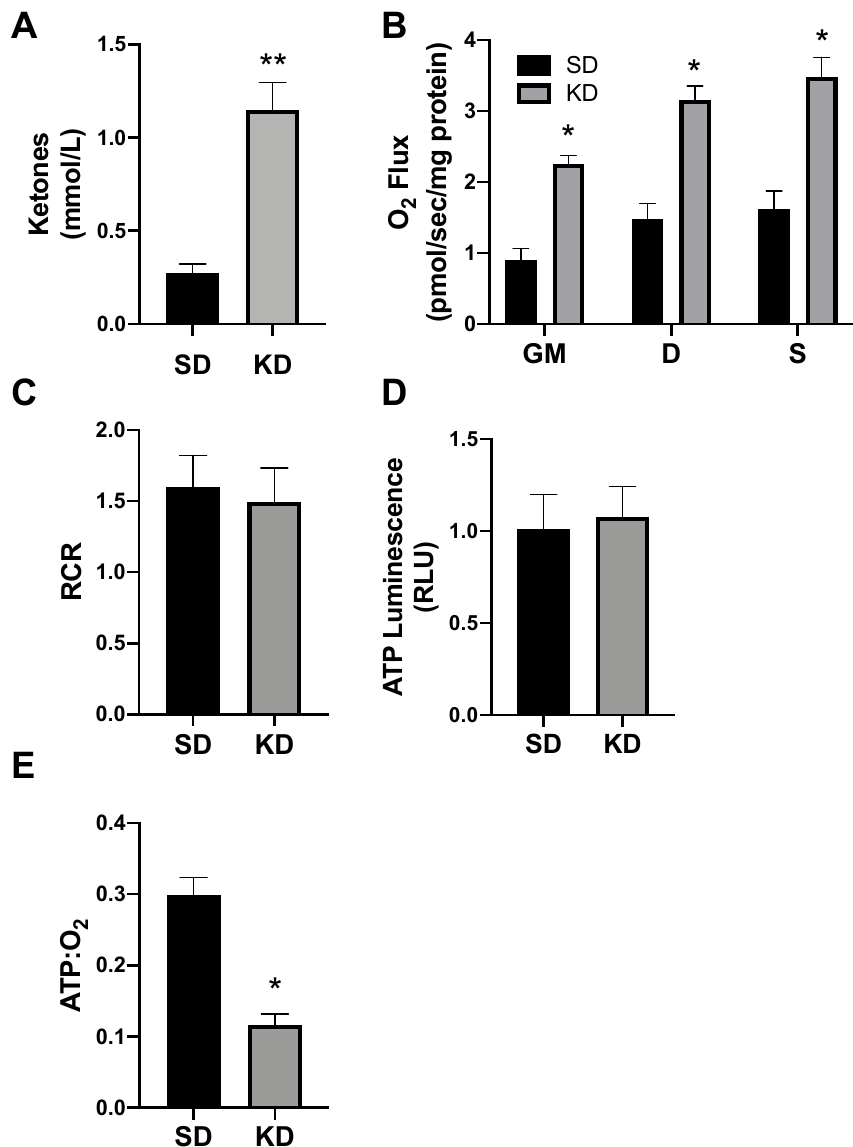
Figure 8. Ketosis alters human subcutaneous adipose mitochondrial bioenergetics. A subcutaneous adipose biopsy was performed in adults adhering to a standard American diet (SD; n = 4) or ketogenic diet (KD; n = 5). Ketosis was confirmed via plasma ketone measurements ( A ). Following the adipose biopsy, tissue was permeabilized to measure the mitochondrial respiration ( B ) and respiratory control ratio (RCR; C ). ATP was measured via luminescence following respiration ( D ), and the ratio of ATP and oxygen respiration was quantified ( E ). * p < 0.05. ** p < 0.01.